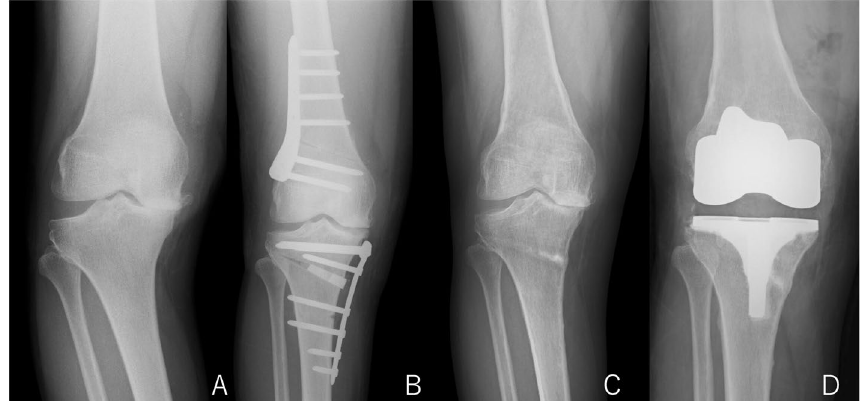
Fig. 3 Serial radiographs of the right knee converted to TKA following DLO, A: A weight-bearing anteroposterior radiograph preoperative JLCA is large (9.7°). B: An anteroposterior radiograph following DLO. C: A weight-bearing anteroposterior radiograph 2 years after DLO. Varus alignment was found to be associated with recurrence of large JLCA. D: An anteroposterior radiograph following TKA conversion, JLCA: joint line convergence angle, DLO: double level osteotomy, TKA: total knee